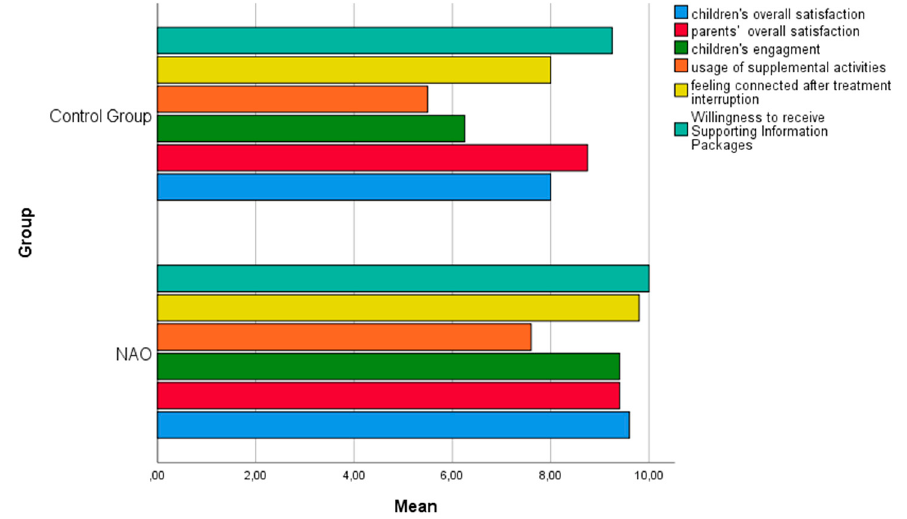
Figure 4. Graphic representation of the group mean variables.